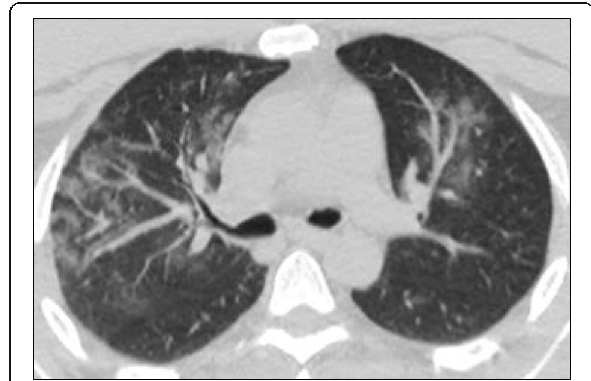
Fig. 4 A 40-year-old male presenting with headache, low-grade fever, and cough. His PaO 2 /FiO 2 ratio was 350 mmHg. Axial thin- section unenhanced CT image shows bilateral upper lobe vascular enlargement within surrounding dense ground-glass opacities with interstitial thickening